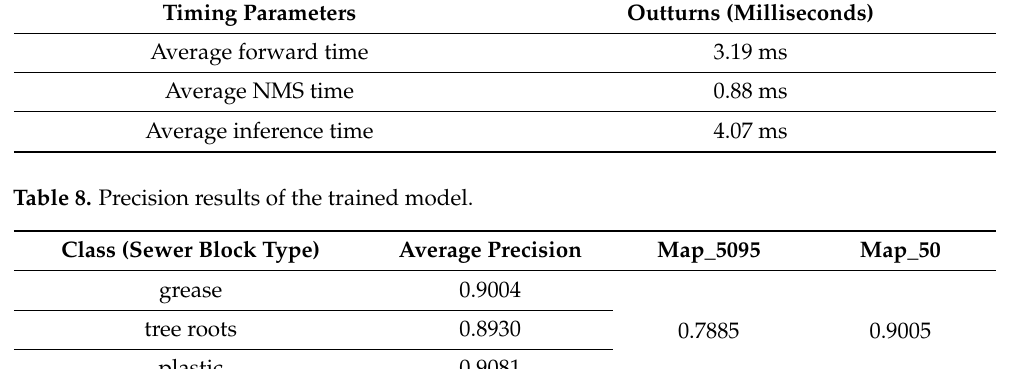
Figure 19. Visual upshots of detected tree roots, plastic and grease types of sewer blocks. 5.3. Embedded Vision with S-BIRD The embedded vision is a pioneering and comprehensive platform for real-world visual implementations in the areas of home life equipment, health, daily services, security through detection and tracking, etc. [21,22]. So, the object detection model trained using S-BIRD will be a significant addition to existing or newly developed embedded vision-based sewer robotic systems. PIRAT [23], KARO [24], KURT [25], MAKRO [26], KANTARO [27], SIAR [28], etc. are some of the popular developments in the field of sewer robotics that serve the purpose of sewer inspection. Figure 20 shows the block diagram of an automated system that has a power-driven cutting tool to remove sewer blocks located by a detector trained using S- BIRD.